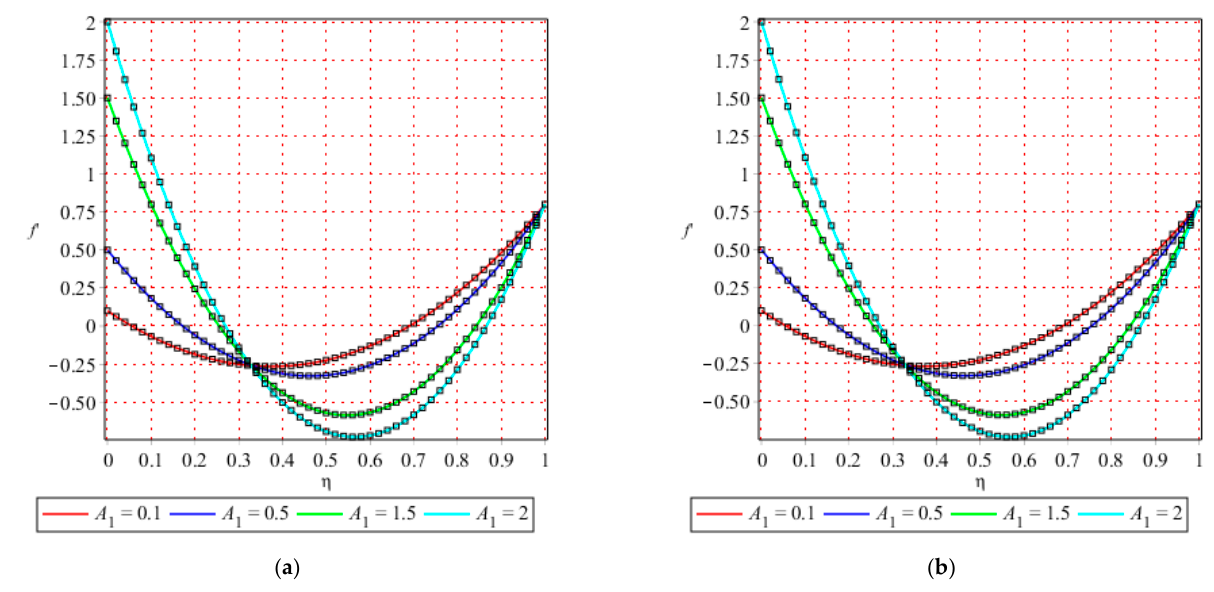
Figure 6. Influence of A 1 on f (cid:48) ( η ) . ( a ) SWCNTs , ( b ) MWCNTs .